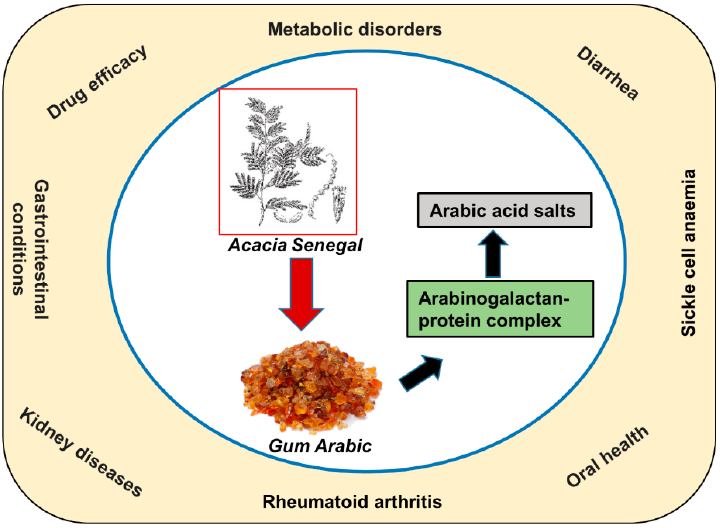
Figure 4. A schematic diagram depicting the beneficial effects of GA on various medical